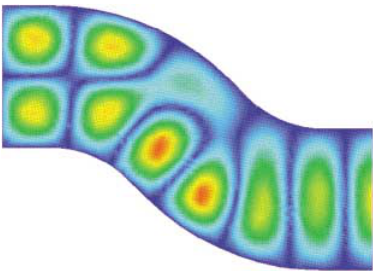
FIG. 6. (Color) Jog converter geometry with simulated electric field plots illustrating conversion from TE 20 to TE 10 (left to right) or from TE 10 to TE 20 (right to left).